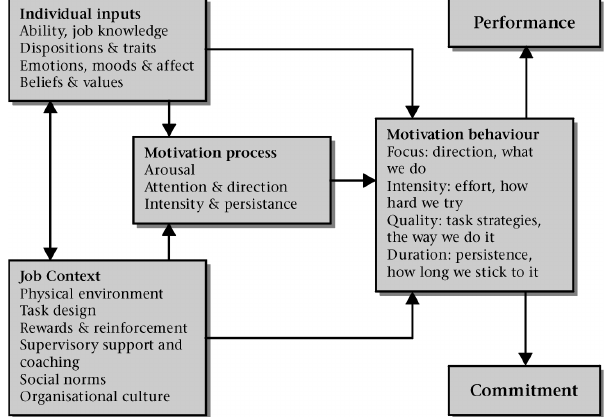
Figure 1: Integrated elements of motivational